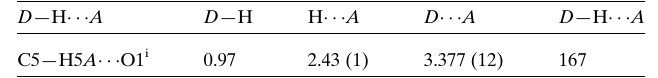
Table 1 Hydrogen-bond geometry (A˚ , (cid:3) ).